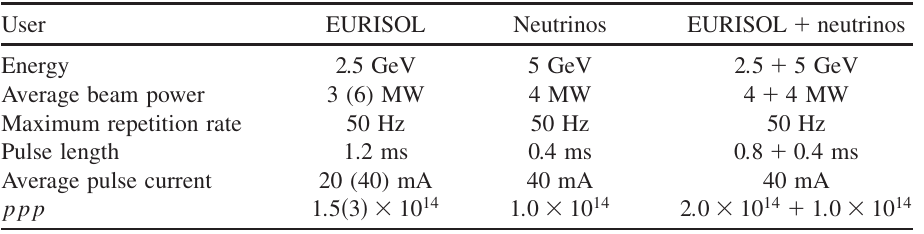
TABLE III. Possible SPL beam parameters for high-power operation.